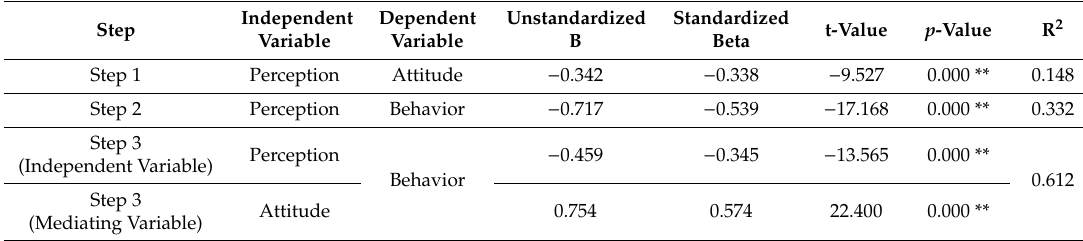
Table 4. Testing the high-involvement model.